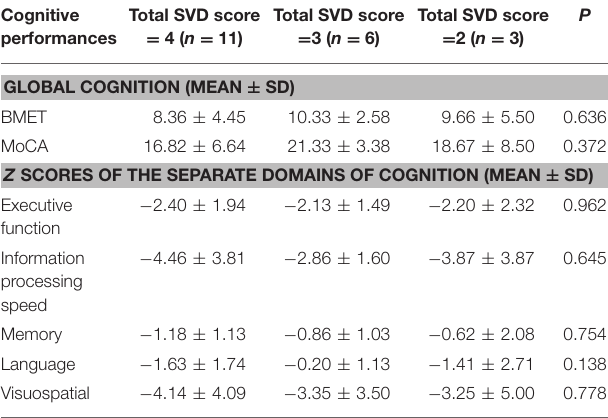
TABLE 3 | The association of the total SVD score and cognitive performance in patients with CADASIL.